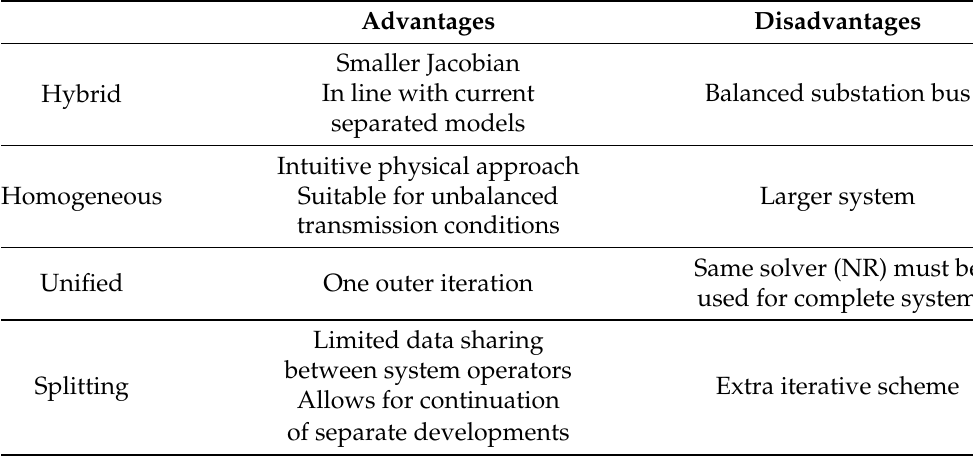
Table 3. Advantages and disadvantages of the network models and integration